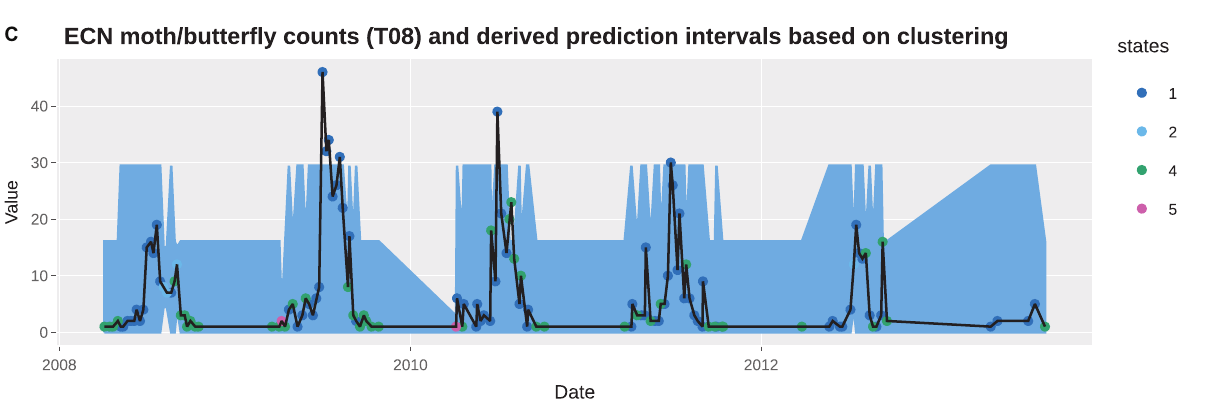
FIGURE 4 | Observed total counts and 95% prediction intervals at Wytham: (A) total moths, (B) total Noctuidae (a moth group), and (C) total butterflies.